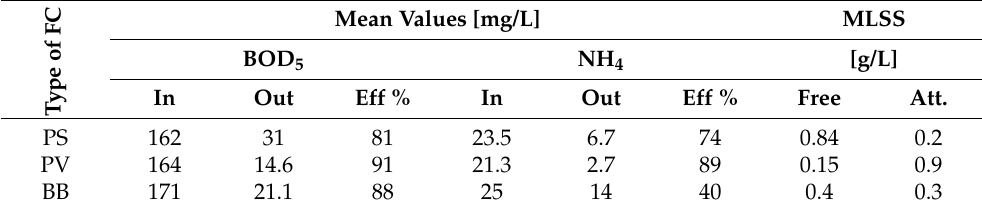
Figure 12. NO 3 concentration dynamics for: PS floating carrier (black); PV floating carrier (green); BB floating carrier (orange). Table 1. Treatment indicators at stage